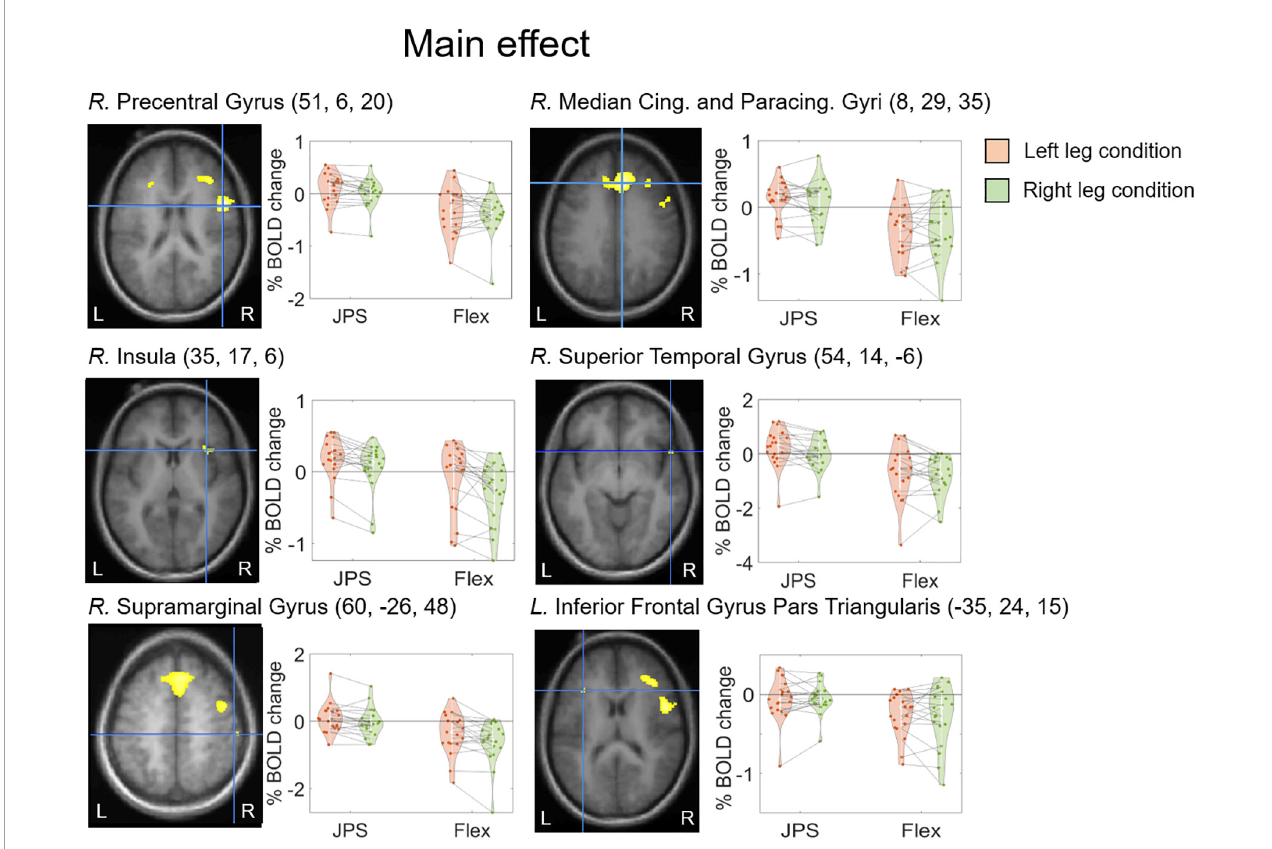
FIGURE2 BOLD response change (%) in the center of peak activation in the brain regions with a significant main effect from condition [ JPS > Rest ] > [ Flex > Rest ], both legs included. The crosshair is centered on the peak voxel of the significant region, visualized on the group mean structural image. Beta representing JPS and Flex are illustrated for both legs (green = right leg condition, orange = left leg condition). Individual means are depicted by the dots and the corresponding means for each leg are joined together by dotted lines. The MNI coordinates corresponding to peak activation are provided in parentheses (X, Y, Z). Cing., Cingulate; L., left; JPS , joint position sense; Paracing., Paracingulate; R.,